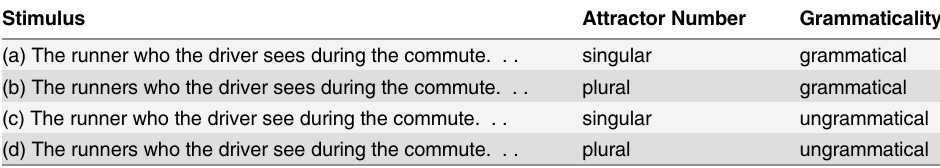
Table 6. Example stimuli set, Experiment